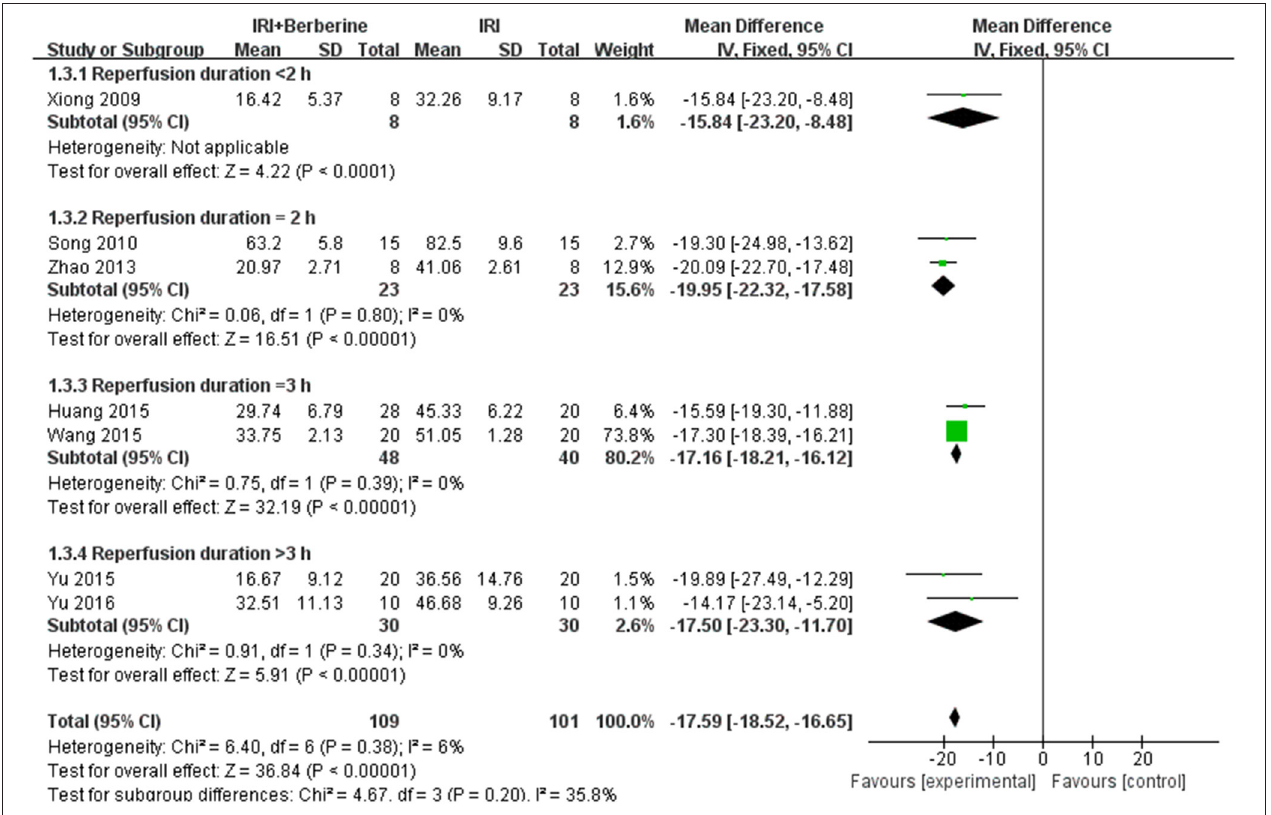
FIGURE 3 | Forest plot: effects of BBR on decreasing the myocardial infarction size compared with the control group.